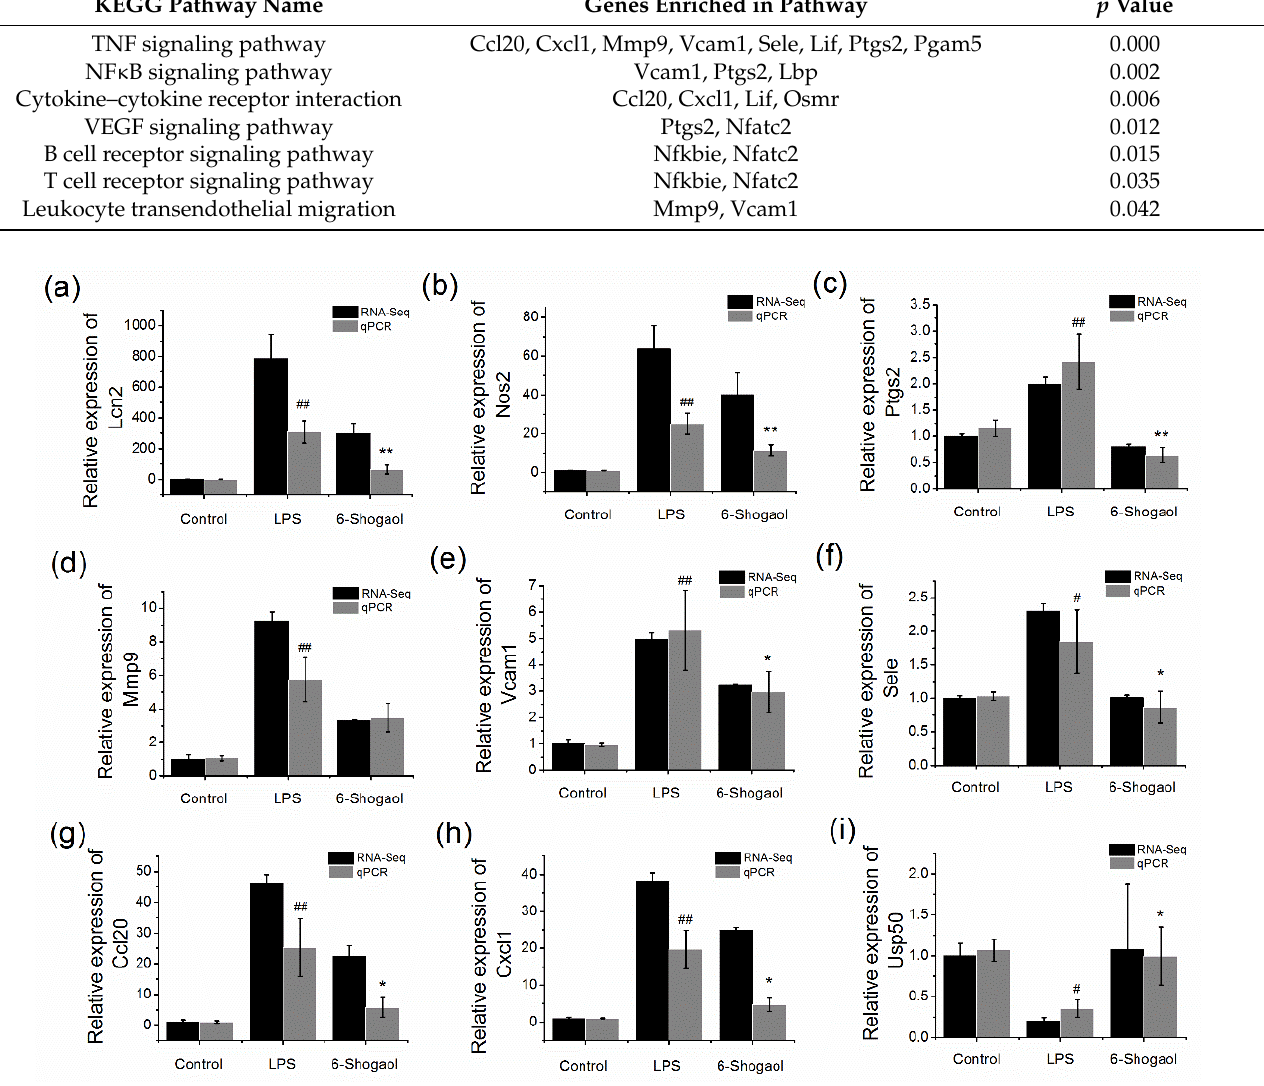
Figure 4. Validation of transcriptome data by qPCR: ( a ) mRNA expression of Lcn2; ( b ) mRNA expression of Nos2; ( c ) mRNA expression of Ptgs2; ( d ) mRNA expression of Mmp9; ( e ) mRNA expression of Vcam1; ( f ) mRNA expression of Sele; ( g ) mRNA expression of Ccl20; ( h ) mRNA expression of Cxcl1; ( i ) mRNA expression of Usp50. Data are presented as mean ± SEM ( n = 3). # p < 0.05, ## p < 0.01 versus control group; * p < 0.05, ** p < 0.01 versus LPS group.